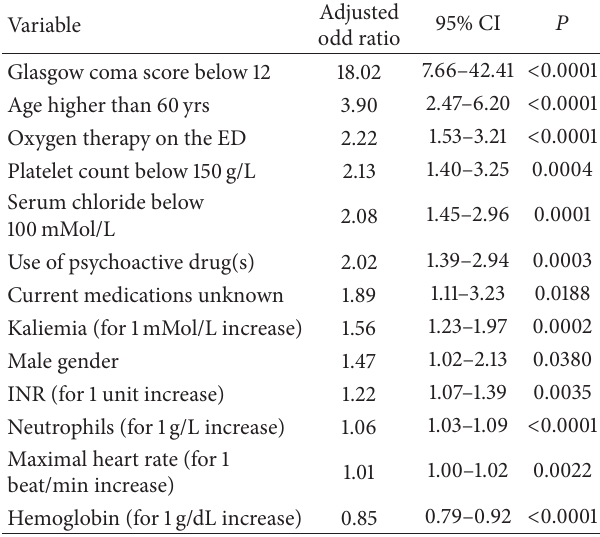
Table 4: Factors retained by multivariate logistic regression to predict hospital death (of all causes) in our population.